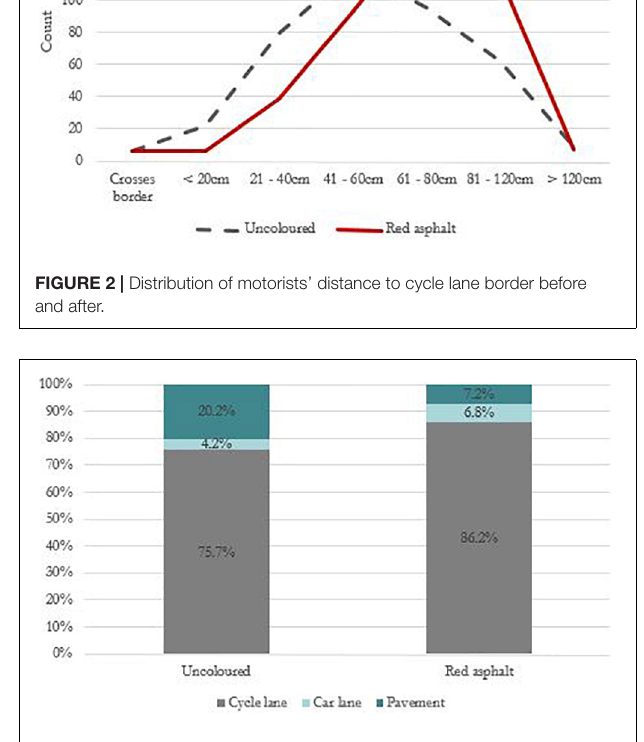
was a reduction in the shortest passing distances as the whole curve moved further away from the cycle